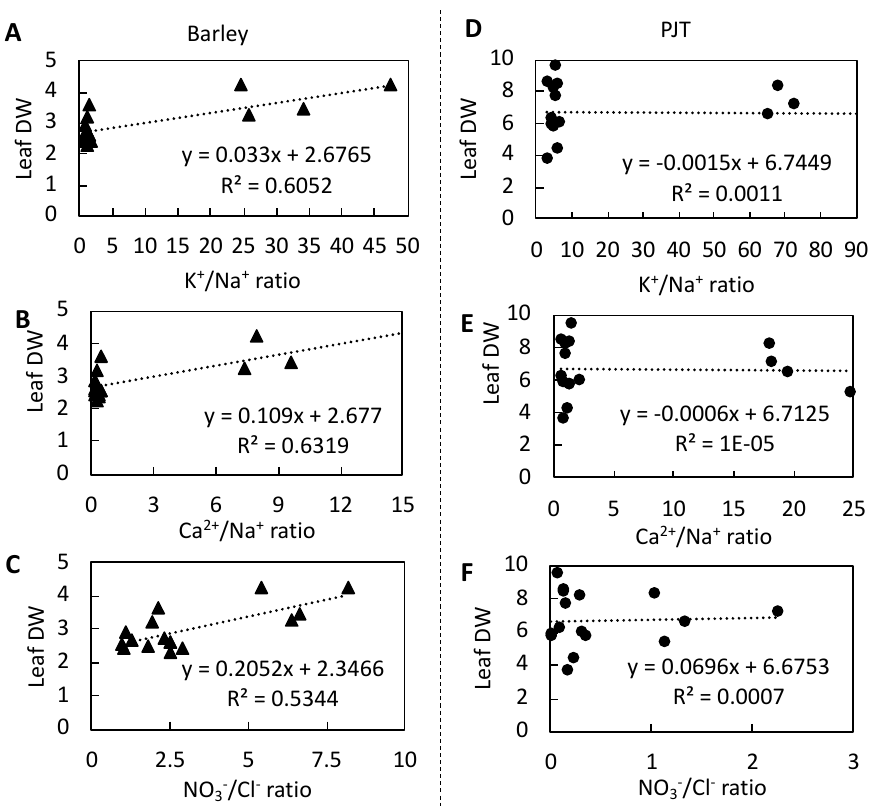
Figure 5. Correlations between ionic balances (K + /Na + , Ca 2+ /Na + , and NO 3− /Cl − ) in barley leaves ( (cid:78) ) and dry leaf weights ( A – C ) and Peucedanum japonicum leaves (•; PJT) and dry leaf weights ( D – F ) at different NaCl concentrations.